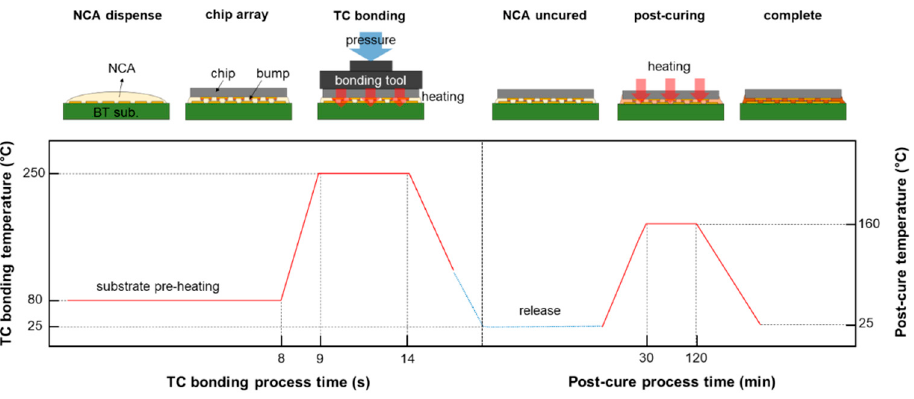
Figure 4. Schematic of bonding process with temperature profile of the TCB process and the post‑ cure